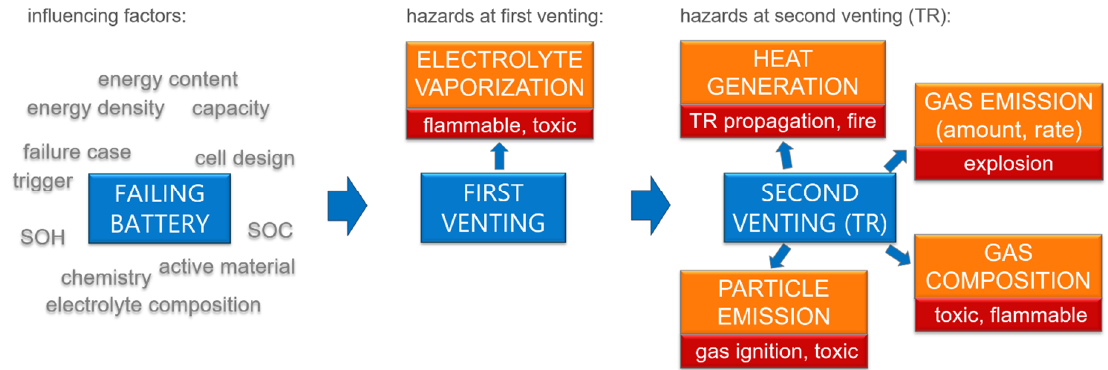
Figure 1. A failing battery can lead to hazards at the first venting and at the TR. Five categorized hazards (orange) and their consequences on safety and health (red) are presented. The battery failures are influenced by several factors.